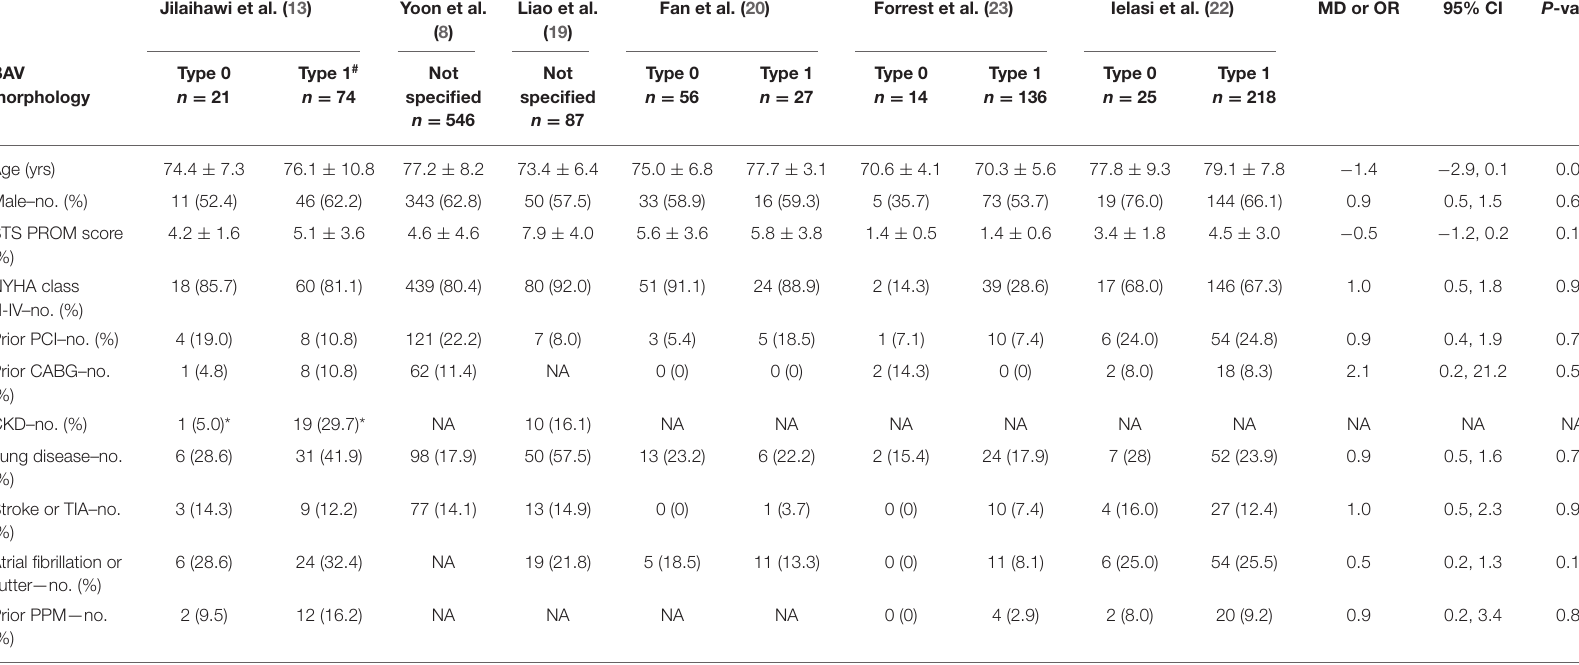
TABLE 3 | Clinical